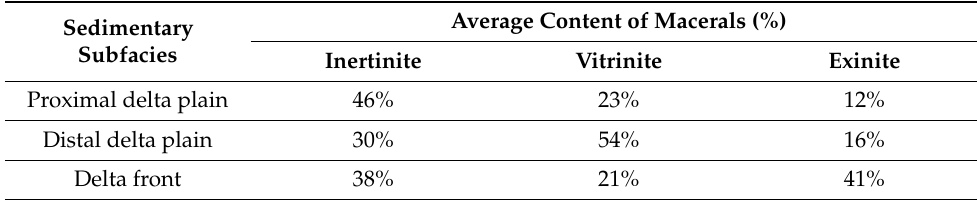
Figure 11. Total organic carbon (TOC) content and hydrocarbon generation potential (S 1 + S 2 ) of the Mungaroo Formation source rocks (mudstone, carbonaceous mudstone, and coal) in different sedimentary facies or subfacies. Table 1. Statistics of the average content of the organic maceral compositions in different sedimentary facies of the Mungaroo Formation in the NCB.